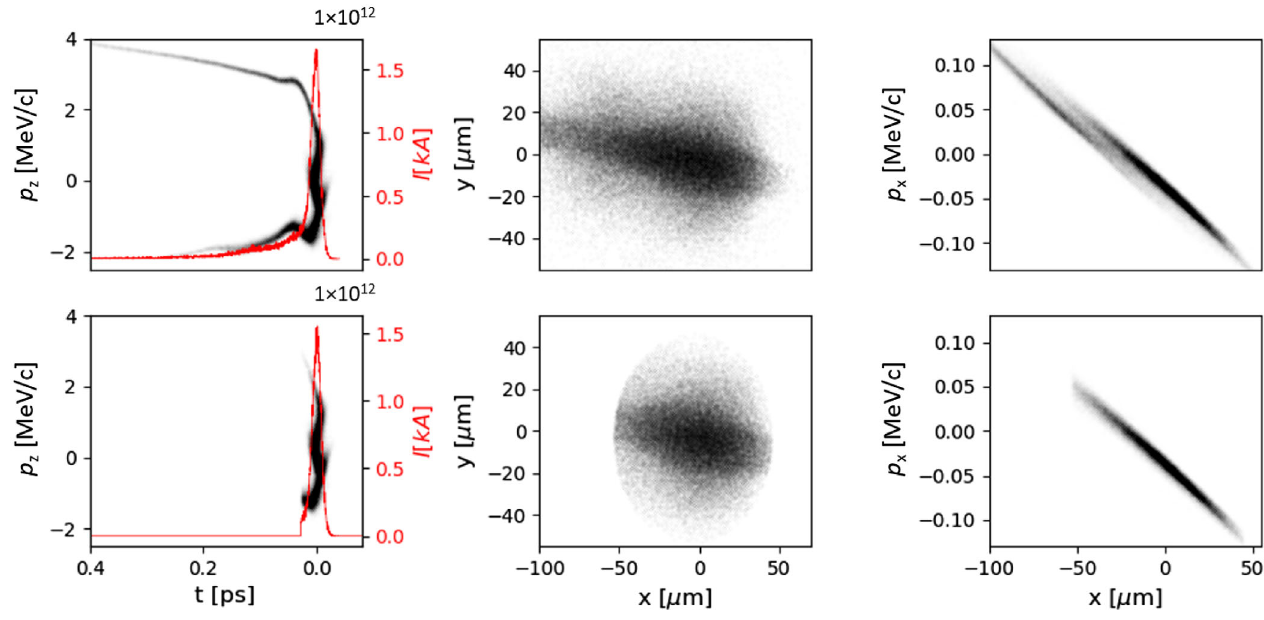
FIG. 12. Final distributions obtained with the S2E simulations. Top row shows: the LPS, the transverse plane and the transverse phase space. The bottom row shows the same plots but for the best particles subset that represents more than 60% of the whole distribution (31 pC on 50 pC bunch